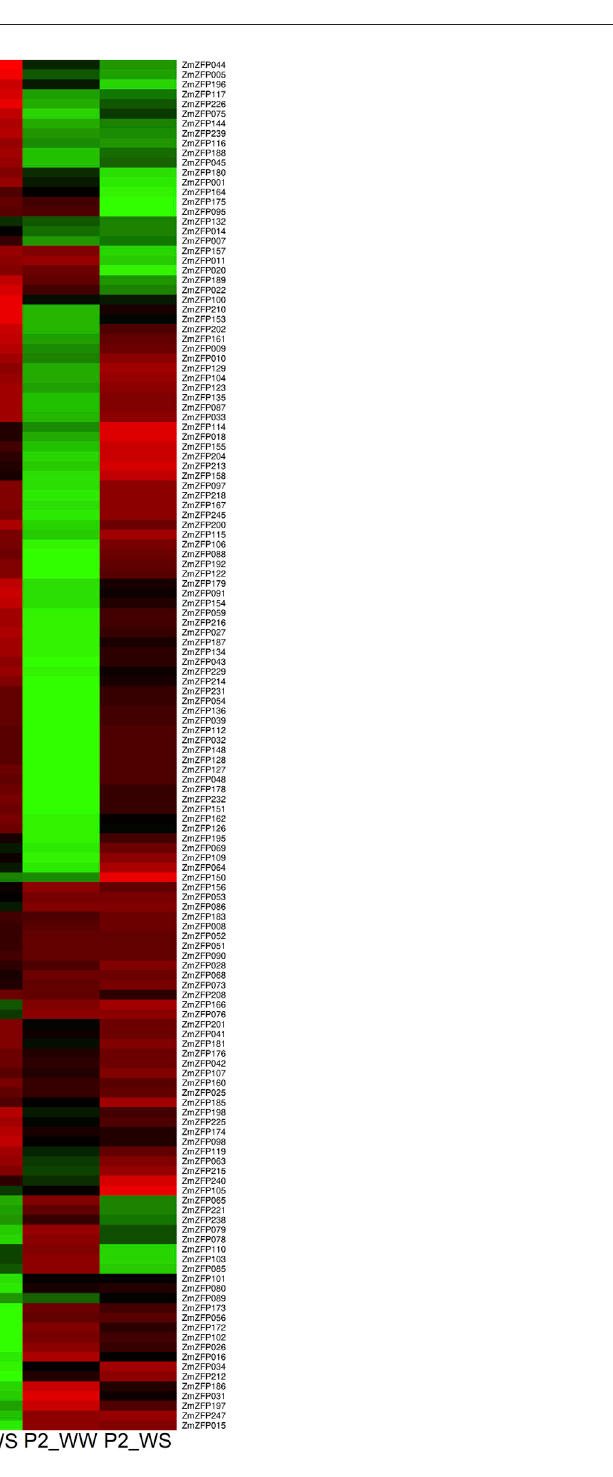
FIGURE 3 | Expression pro fi les of Ac7643 inbred line (drought tolerance) and P2 inbred line (drought sensitive) C2H2-ZF genes under water-stressed conditions. The green, red, and black represent positive, negative, and zero gene expression levels, respectively. Heat map hierarchical clustering of log 2 transformed gene under water-stressed. P1_WW: expression of Ac7643 inbred line under well-watered conditions; P1_WS: expression of Ac7643 inbred line under water-stressed conditions. P2_WW: expression of Ac7729/TZSRW inbred line under well-watered conditions; P2_WS: expression of Ac7729/TZSRW inbred line under water-stressed